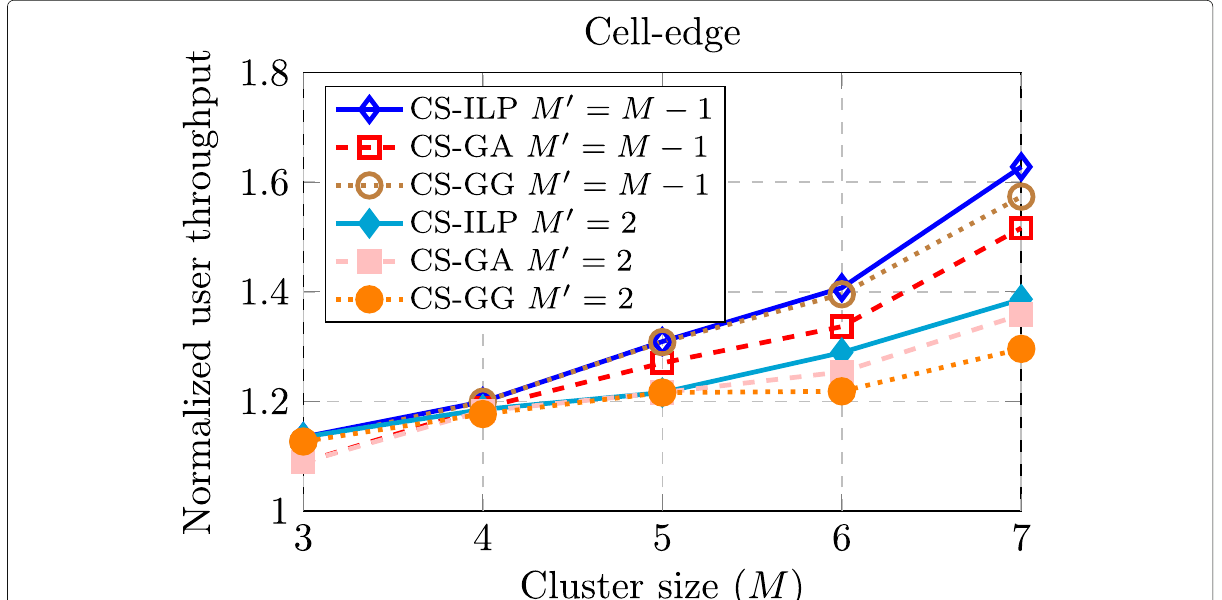
Fig. 4 Average cell-edge user throughput, normalized with respect to the non-coop. PFS, for different cooperation cluster sizes ( M ) . Scenario with N = 10 M UEs, L = 10 PRBs and M (cid:4) = { 2, M − 1 } BSs. There is out-of-cluster